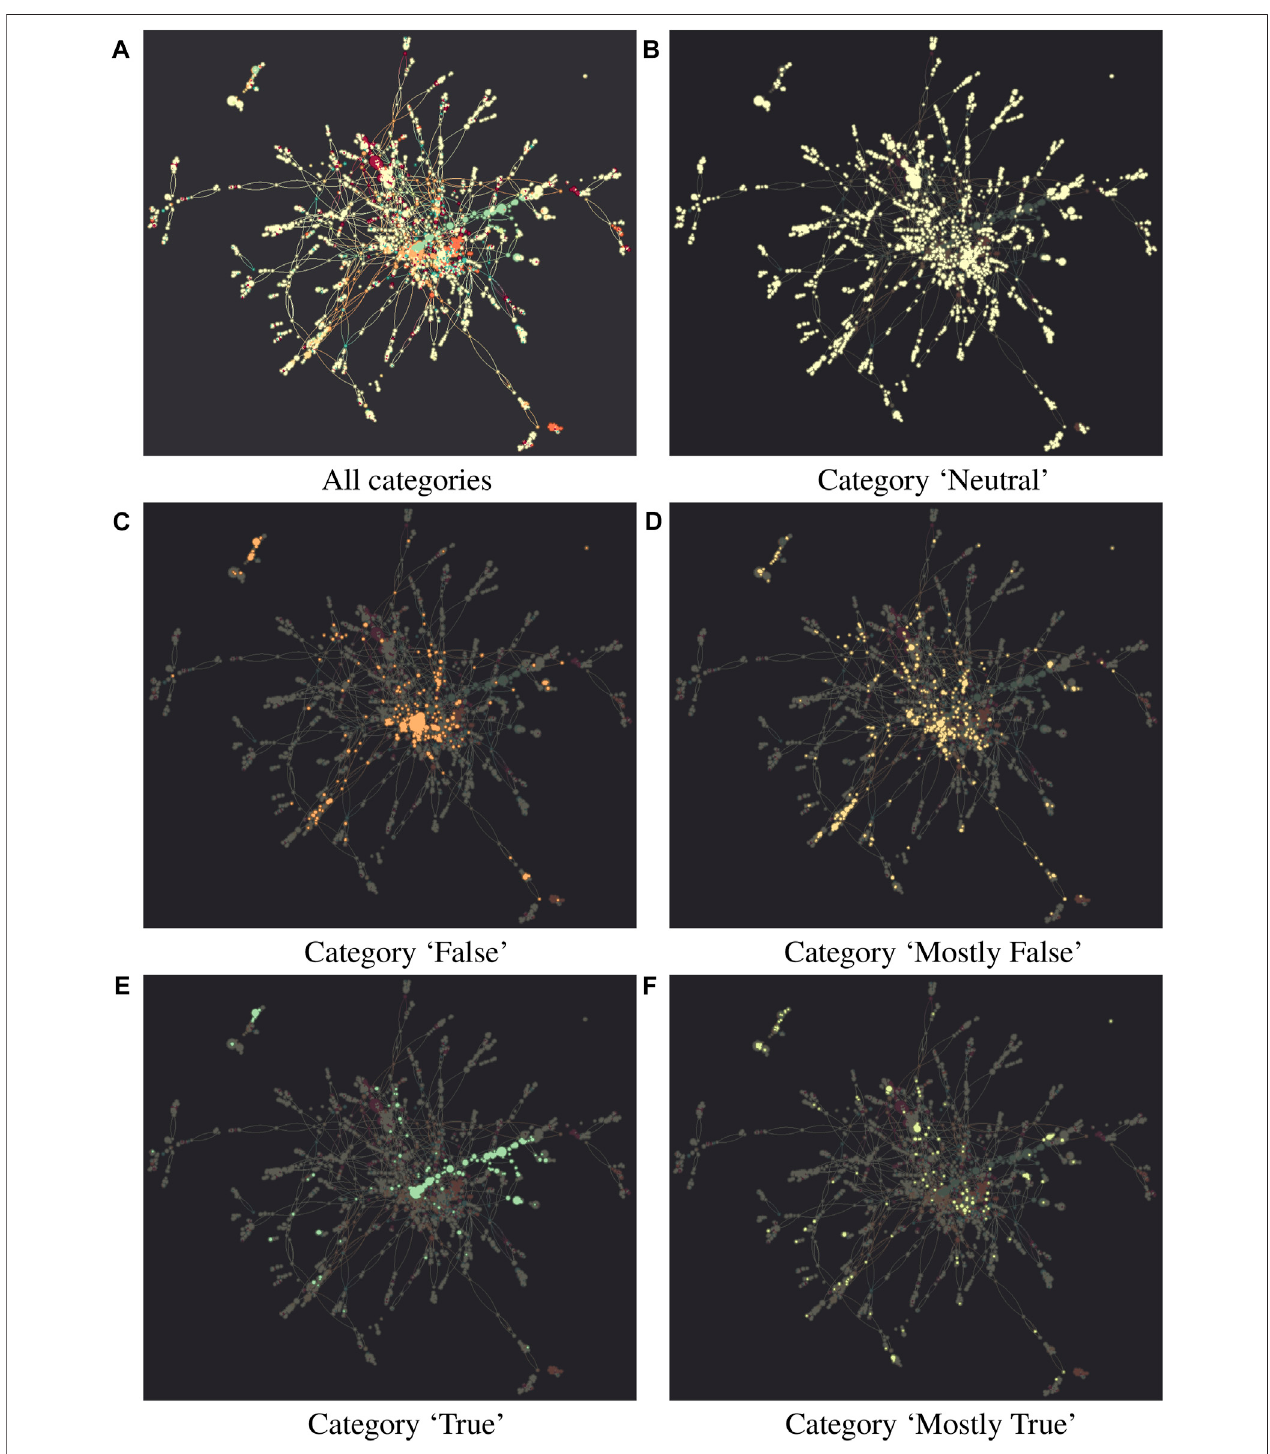
FIGURE 3 | Full network (A) comprises websites whose relationships are based on audience overlap. Node size is proportional to node degree, while its color is determinedbytheattributeinformationassociatedwithit,usingaSpectralpaletteinGraphistry.Inlightyellow,therearewebsitesinthe “ Neutral ” category (B) ;inorange, there are websites in the “ False ” category (C) ; in light orange, there are websites in the “ Mostly False ” category (D) ; in dark sea green, there are websites in the “ True ” category (E) ; fi nally, in light green, there are websites in the “ Mostly True ” category (F) . Included in the full network, in dark orange, there are websites in the “ Download/Streaming/Betting and Adult content ” category, while in red, there are websites in the “ Scam/Negative reviewed/Crypto payment ” category. Isolated (standalone) nodes are hidden in the fi gure.